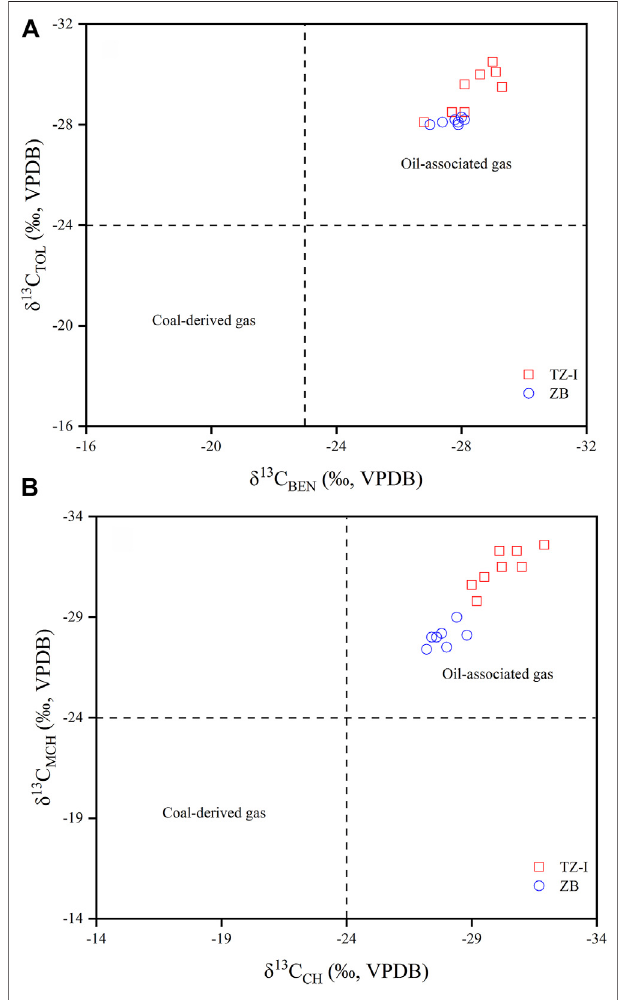
FIGURE7| δ 13 C BEN verse δ 13 C TOL (A) , δ 13 C CH verse δ 13 C MCH (B) cross plots of natural gases from TZ-I and ZB gas fi elds (modi fi ed from Hu et al.,